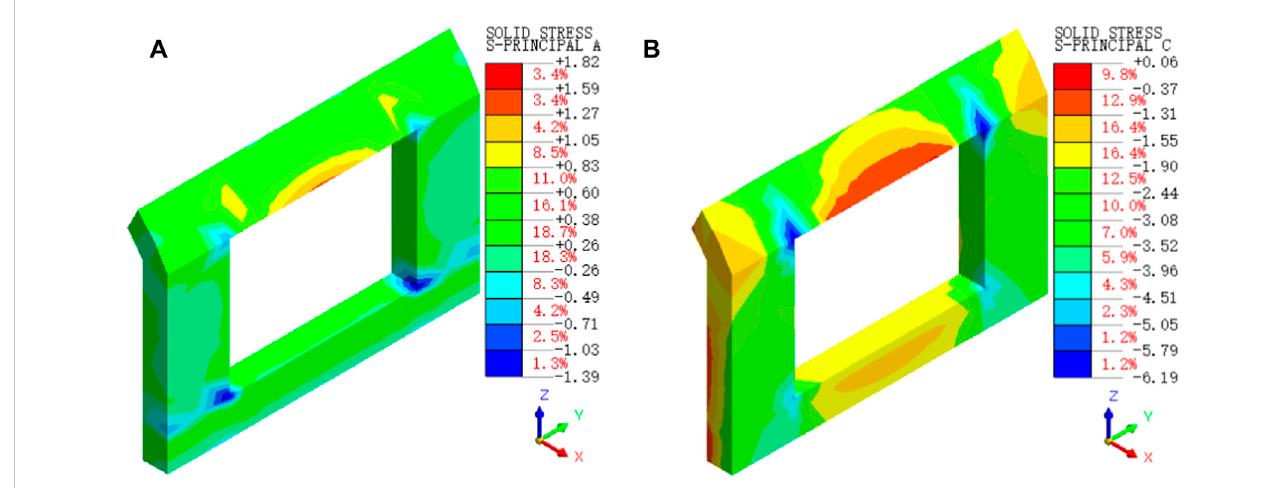
FIGURE 12 Principal stress distribution around the side wall opening (MPa): (A) First principal stress and (B) Third principal stress.